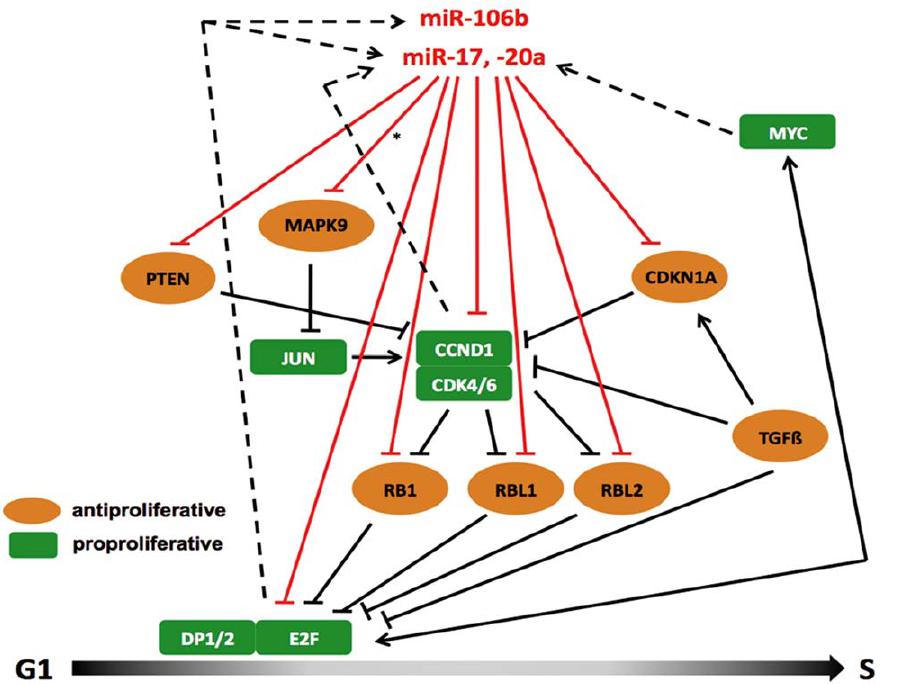
Figure 6. Relationships between pro-proliferative and anti-proliferative proteins involved in G 1 /S transition and miR-17, miR-20a, and miR-106b. Pro-proliferative proteins are shown as green squares, anti-proliferative proteins are given as orange circles. Black lines denote protein-protein interactions, red lines represent microRNA-protein interactions. Dashed black lines show activatory interactions of proteins on microRNA genes. *Predicted interactions of miR-17, -20a, and -106b and MAPK9 could not be validated in our assay, but an interaction between miR- 17 and MAPK9 had been shown by Cloonan and coworkers [22].